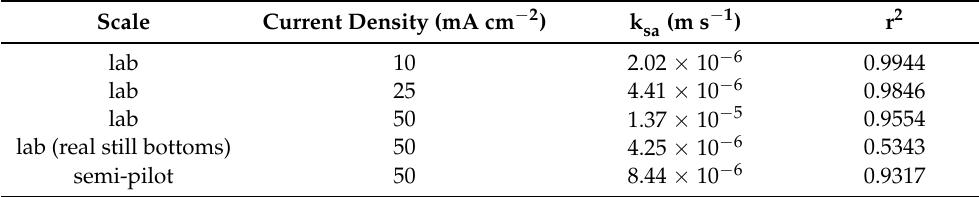
Table A5. Values of surface area normalized pseudo-first-order degradation rate constants for the electrochemical treatment of PFAS in from a synthetic still bottoms